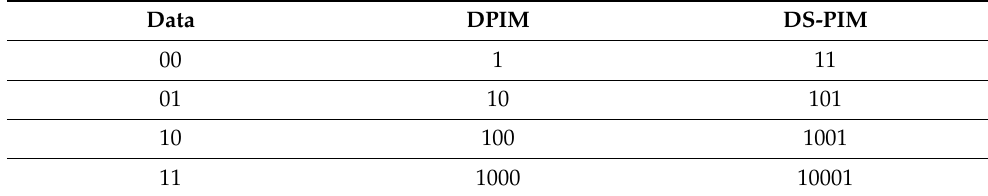
Table 3. Modulation data frame for data, DPIM and DS-PIM.